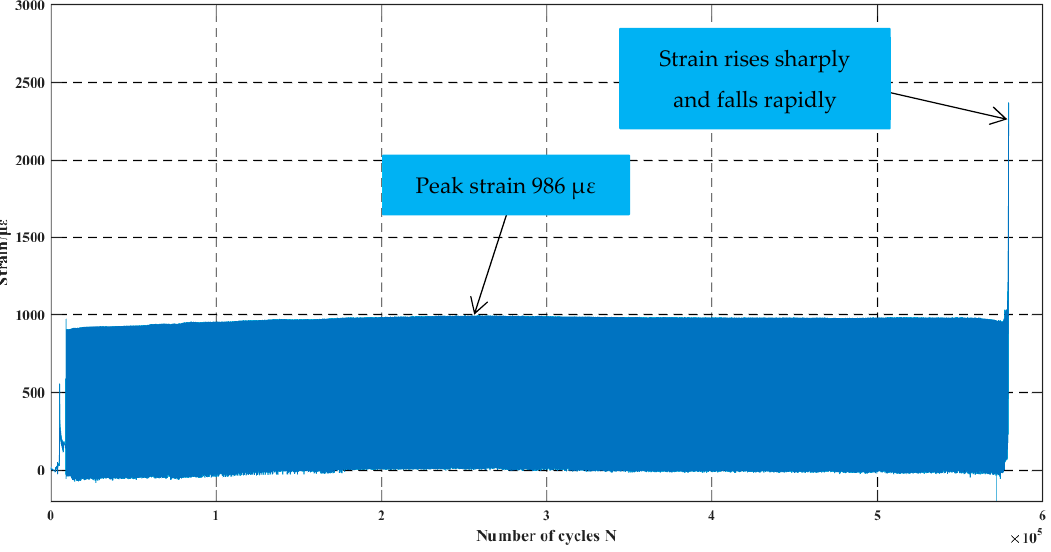
Figure 10. Strain time history curve (testing point 0#).